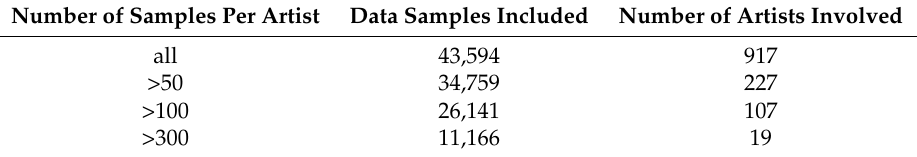
Table 1. Selection of the painting datasets used in this study.